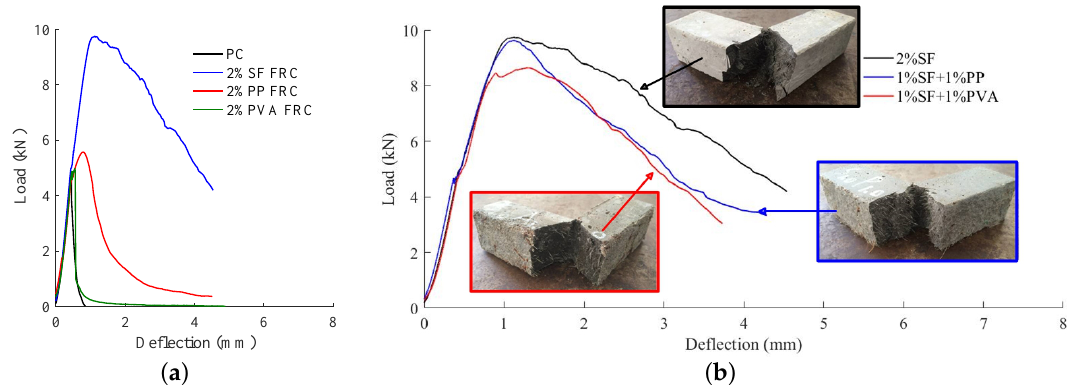
Figure 5. PC and fiber reinforced concrete responses in the 3PBT. ( a ) Load vs. deflection for PC and FRC; ( b ) Bending responses for SFRC and HFRC.